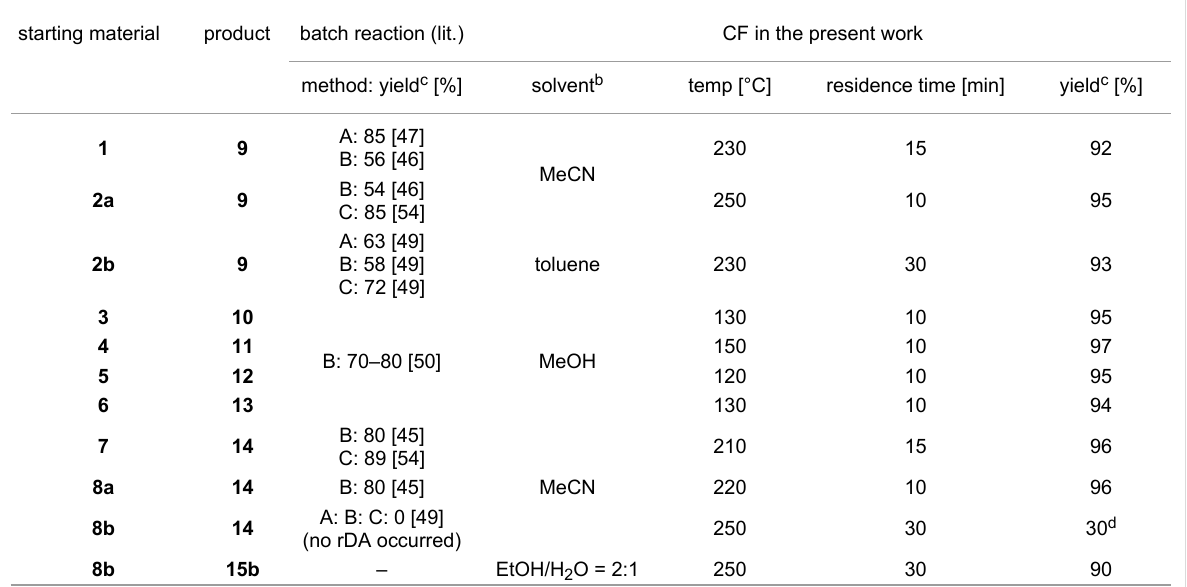
Table 2: Comparison between batch reactions a and the CF process for the synthesis of pyrimidinones 9 – 14 .